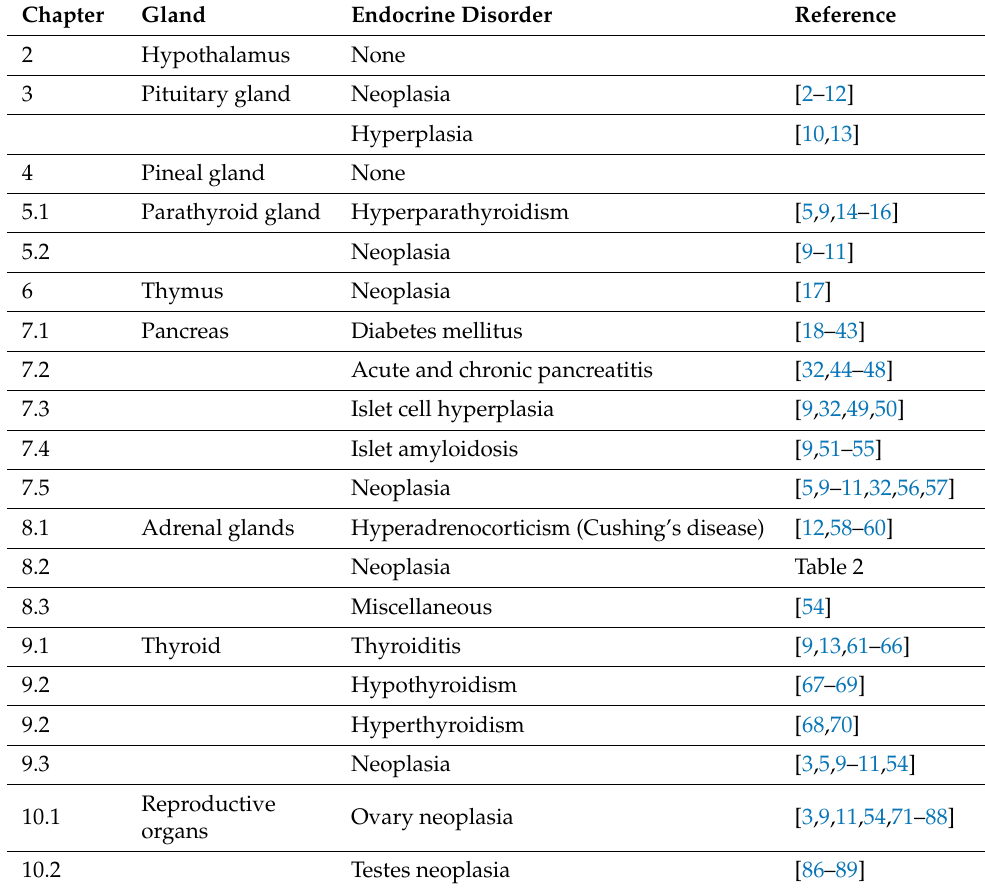
Table 1. Spontaneous endocrine disorder in nonhuman primates: distribution by